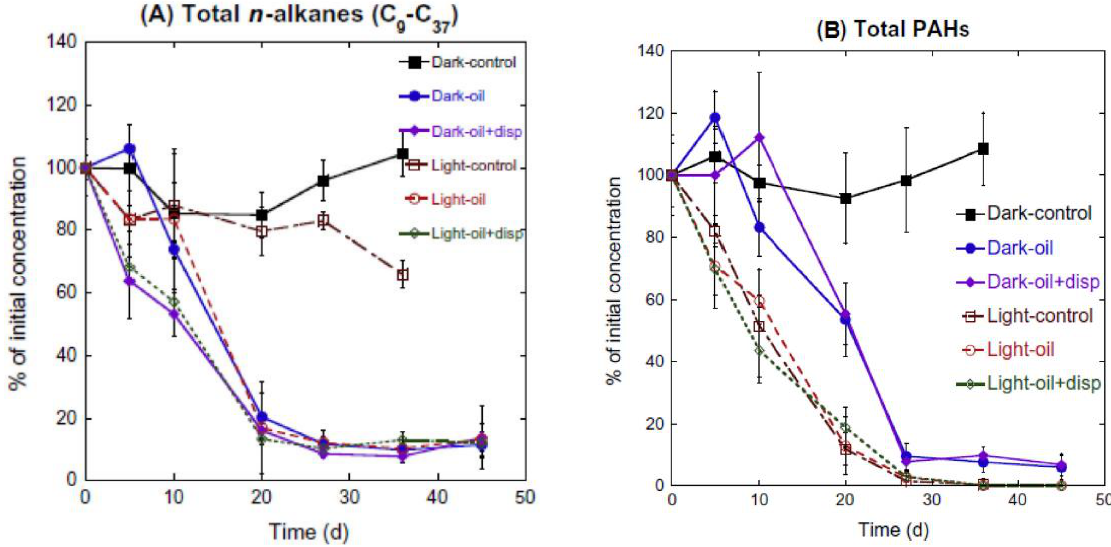
Figure 5. Degradation of total ( A ) n -alkanes and ( B ) PAHs under dark and light conditions. Adapted from Bacosa, et al. [33].